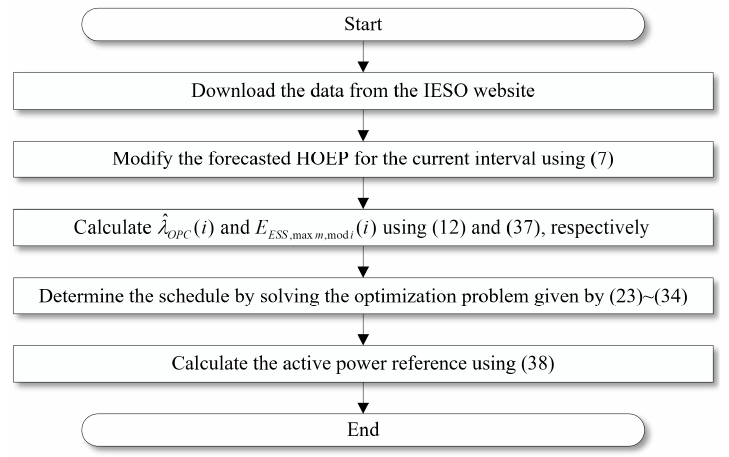
Figure 4. Overall process of the proposed method.